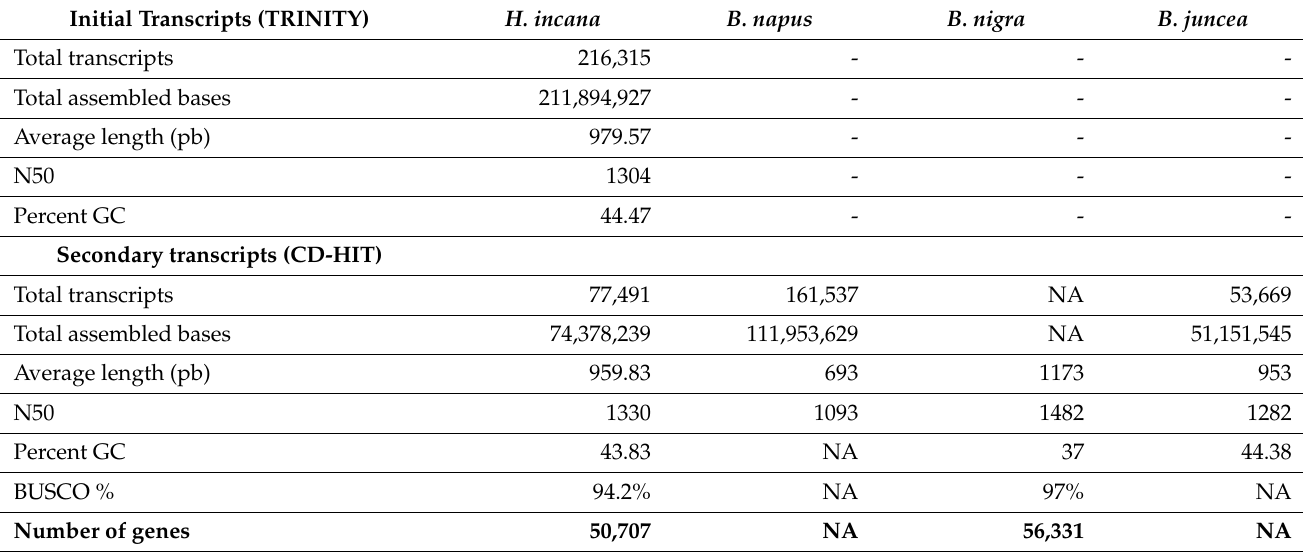
Table 1. Transcriptome comparison of four Brassicaceae species including H. incana, B. napus [31], B. juncea [30], and B. nigra